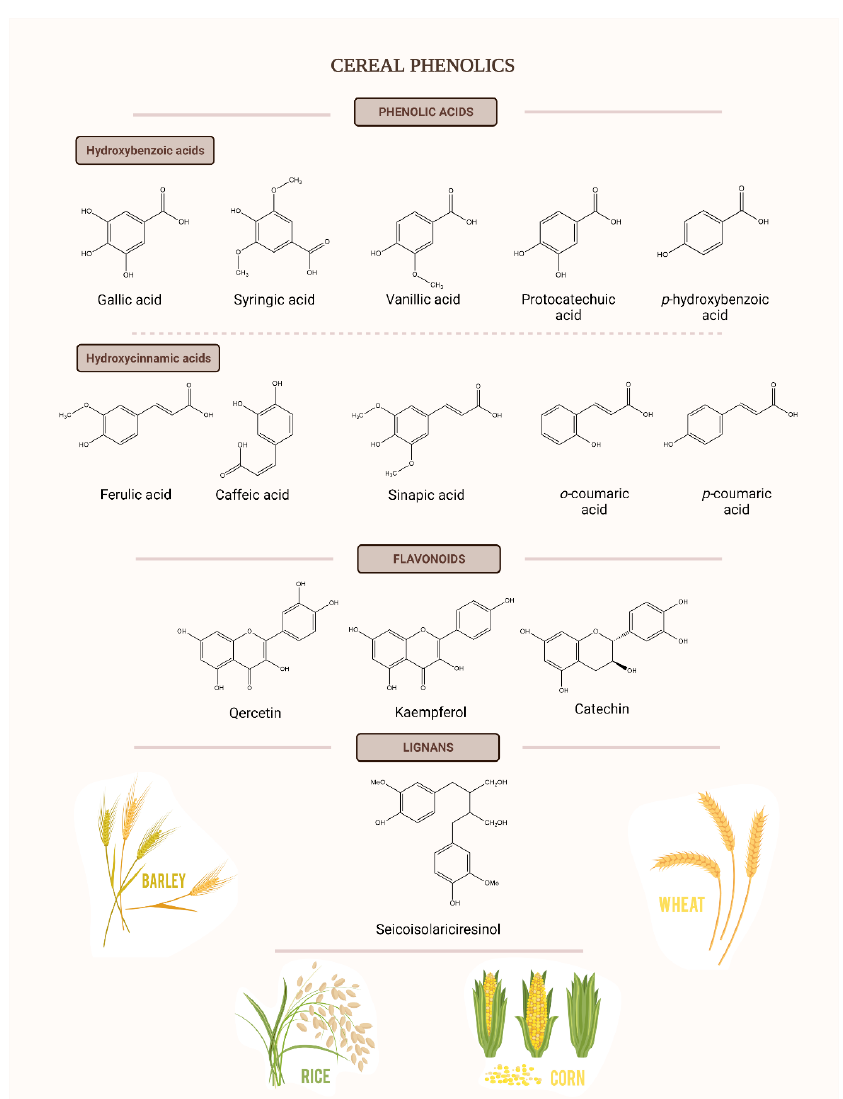
Figure 6. Principal phenolics in cereals (updated after Van Hung, P., 2016 [37]). To obtain final products, cereal grains are usually milled, and during this process, the bran, which is separated from the starchy endosperm of the grain, represents a major by-product. Even though the nutrients are generally present in higher concentration in the outer part of the grain, it is often used as animal feed, being in this way undervalued. By-products contain significant amounts of bioactive compounds with specific health ben- efits, which can be extracted using several techniques, which will be presented further. 4. Extraction Methods As mentioned before, phenolic compounds can be found in different layers of the grain, especially in bran, which represents the hard-outer layers of the cereal. That is the